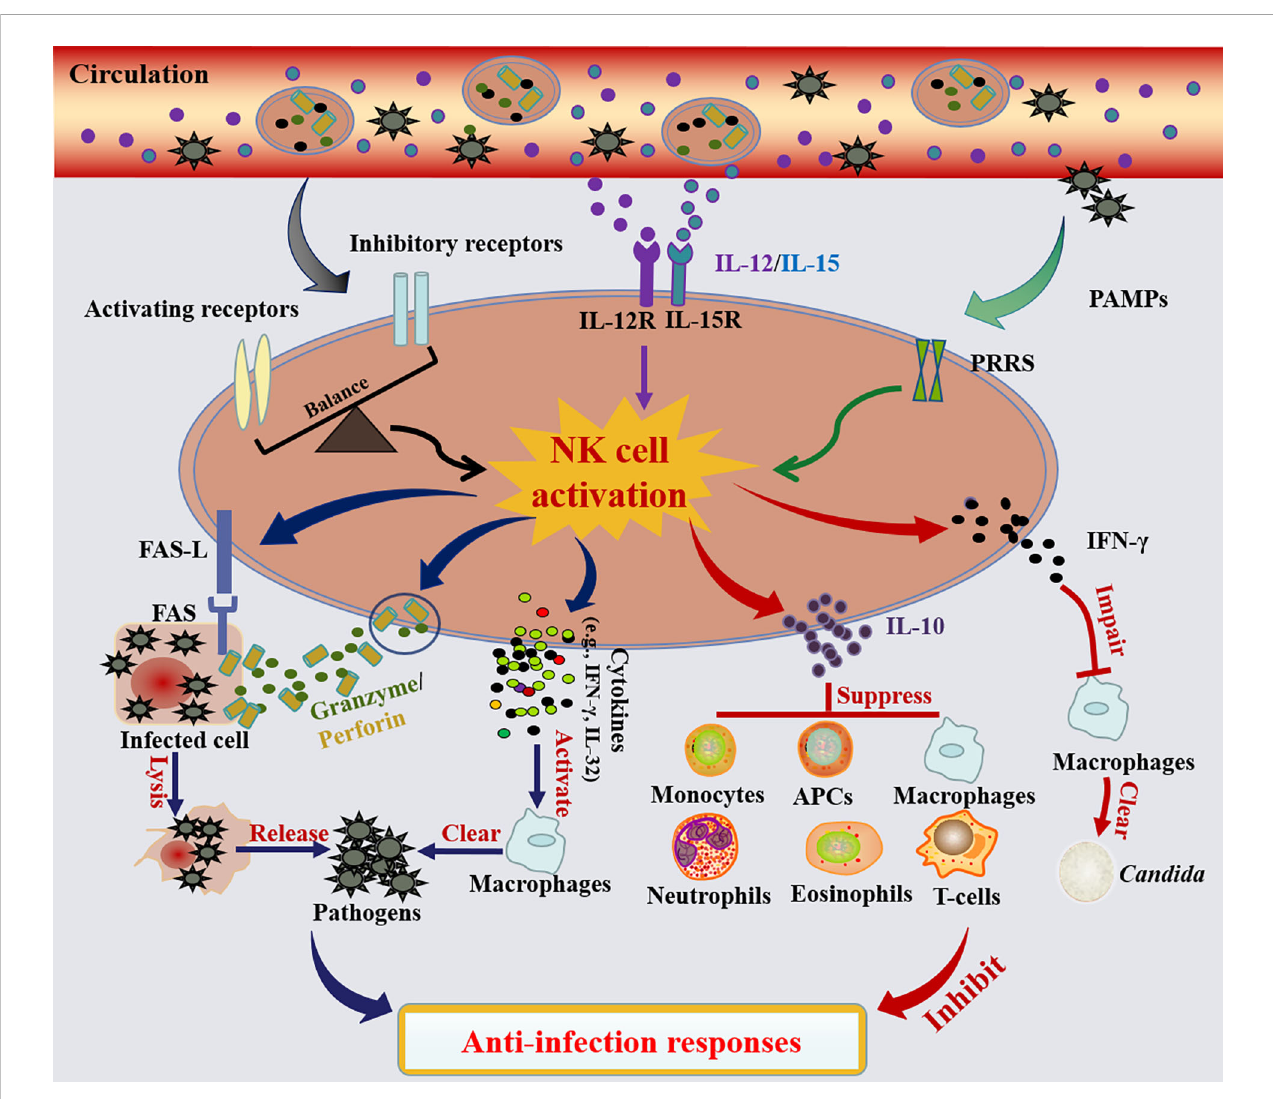
FIGURE 2 NK cell activation and their roles in the anti-infection responses. NK cells are mainly activated in three ways: 1) The activation of NK cells is governed by a balance between signals delivered through activated and inhibitory receptors. When the activating signal dominates, NK cells will be activated, and vice versa. 2) Activation of NK cells can also be achieved by stimulation with cytokines (e.g., IL-12 and IL-15). 3) NK cells are activated by pathogen-associated molecular patterns (PAMPs) through pattern recognition receptors (PRRs). Activated NK cells lysis infected cells and release pathogens via death receptor ligand/death receptor (e.g., FAS-L/FAS) and secreting cytotoxic proteins (e.g., perforin and granzyme). Meanwhile, activated NK cells promote the activation of macrophage-mediated microbial killing by the secretion of cytokines (e.g., IFN- g , IL-32). In contrast, activated NK cells also possess